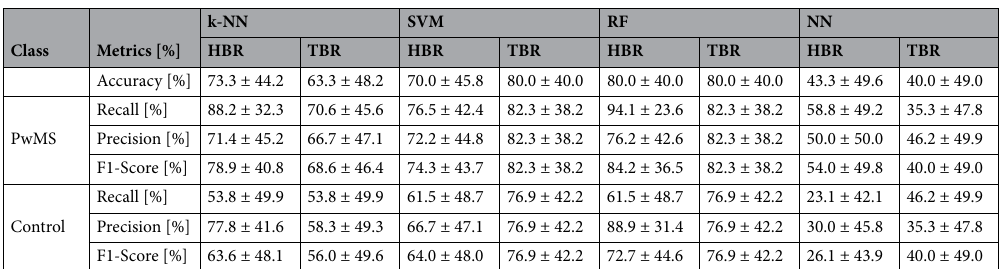
Table 4. Performance of the other ML models with a leave-one-out approach in terms of accuracy, recall, precision, and F1-Score per class, for different sets of features (only HBR features or only TBR features).